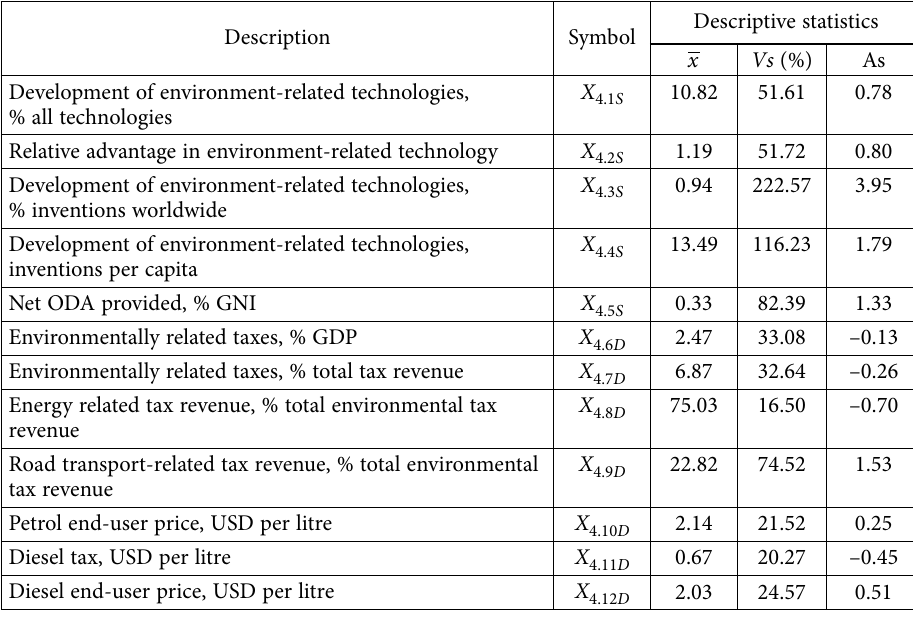
Table 5. Economic opportunities and policy responses (dimension IV)